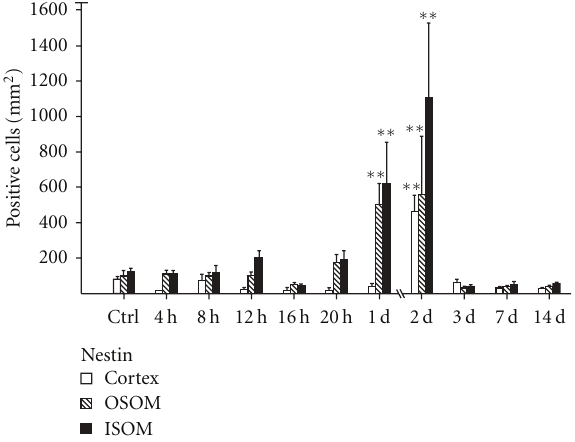
Figure 4: Distribution of nestin immunoreactivity in the renal interstitium from controls (Ctrl) or from animals sacrificed at increasing time intervals (hours or days) after reperfusion. Each column corresponds to the mean number of nestin immunoreactive fusiform cells ( ± SD) after examination of cortex and outer medulla (OSOM, ISOM) for each experimental group ( n = 4) ( ∗∗ P < . 01 versus